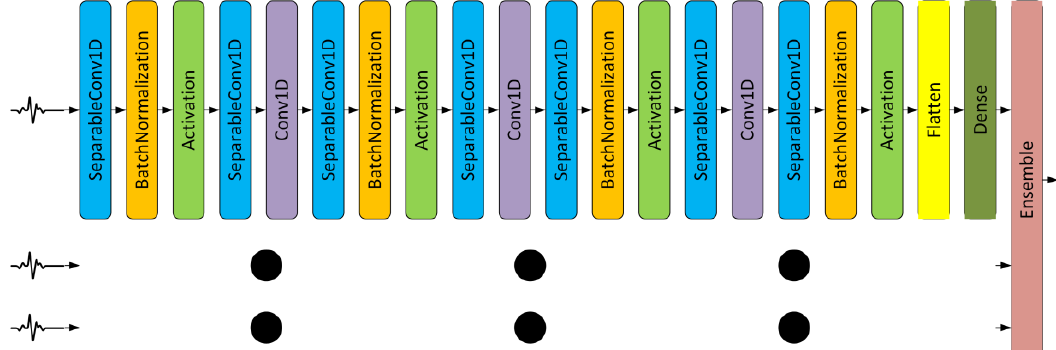
Figure 5. Proposed ensemble of depthwise separable CNNs algorithm.